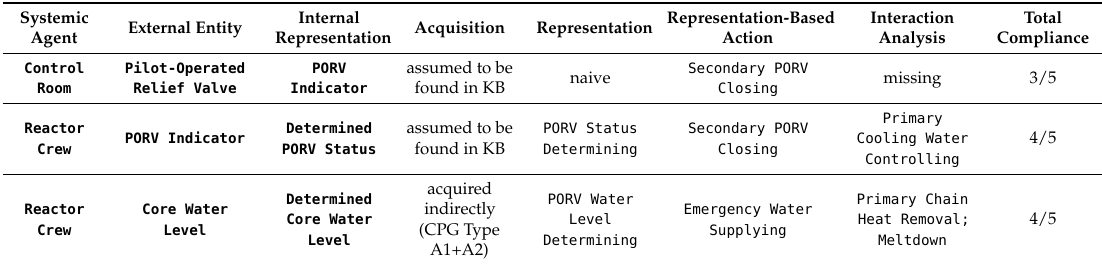
Table 6. TMI2 model compliance with CPGA